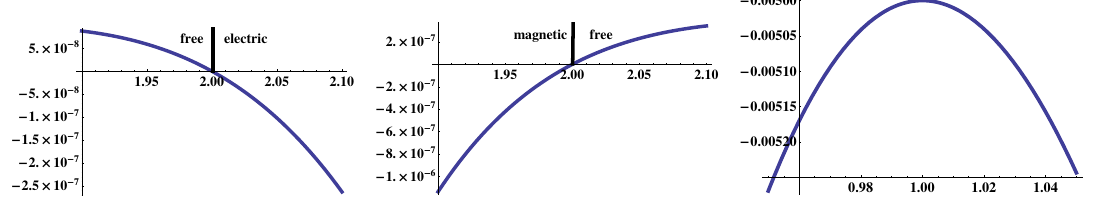
Figure 4 . From left to right: the behavior of (cid:1) S as a function of x pure magnetic, and dYM Coulomb gases. We use appropriate values of (cid:16) and a in order to produce the numerical graphs such that (cid:16)